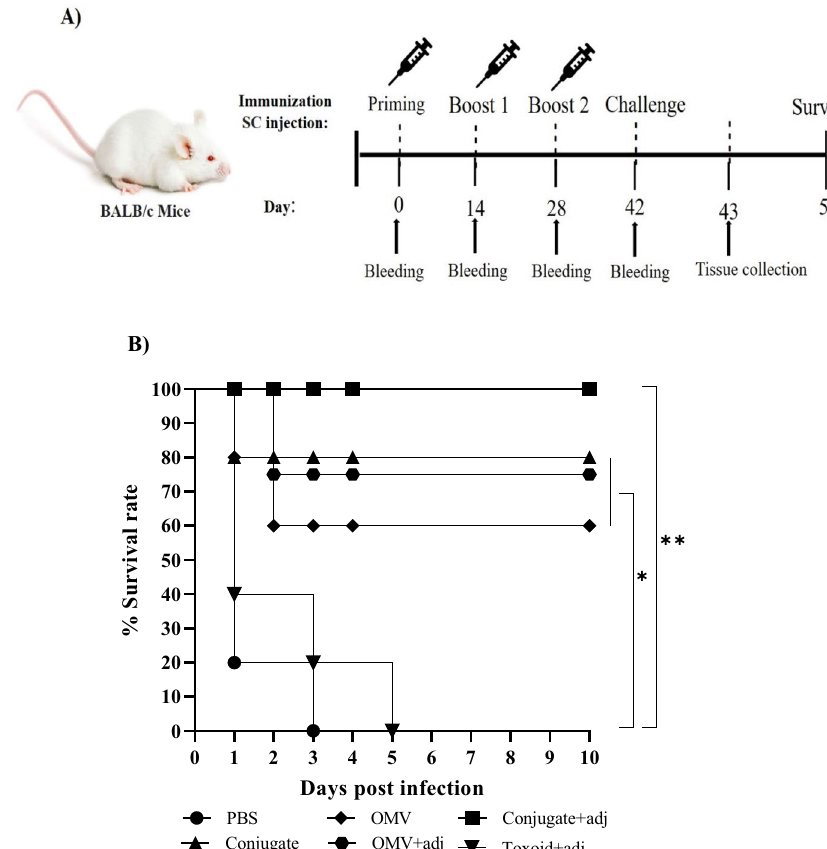
Figure 3. Experimental scheme of mice immunization and survival rate monitoring. ( A ) Schematic presentation of mice immunization. ( B ) The survival rates of immunized BALB/c mice (n = 10) infected with PAO1 (3 × 10 2 CFUs) in the burn model were monitored twice a day for ten days, and rates were analyzed using the log-rank test method. * P < 0.05 and ** P <